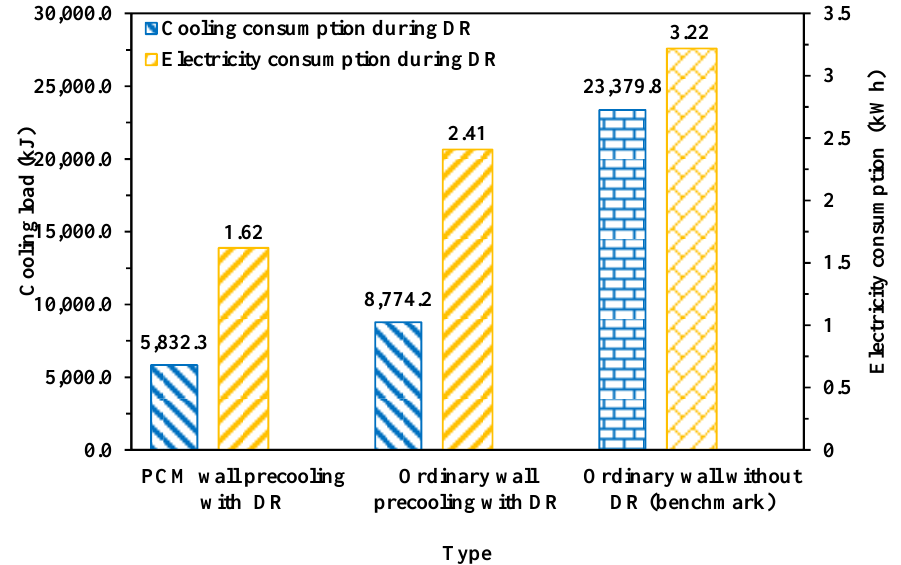
Figure 10. Energy consumption during DR event.